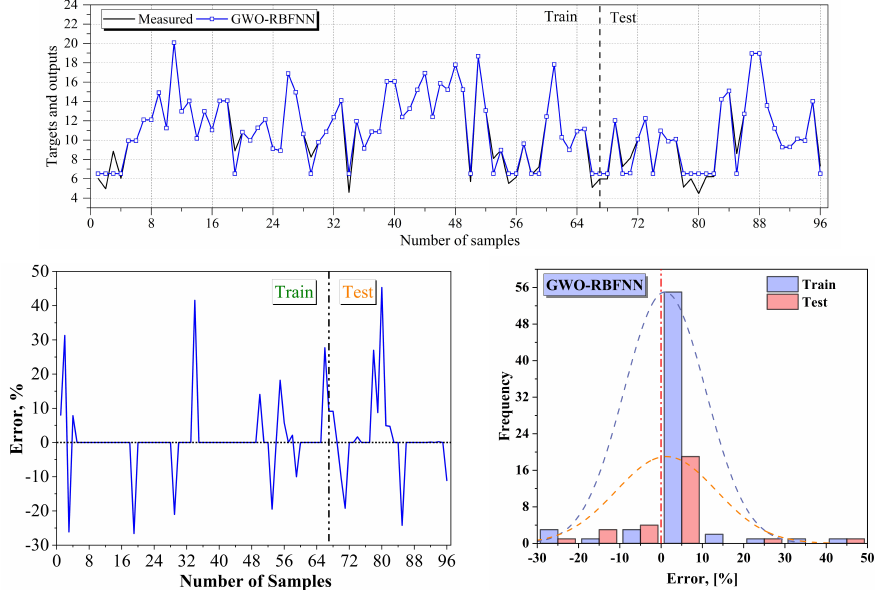
Fig. 10. Train and test stage results of the introduced GWO-RBFNN model in predicting SP